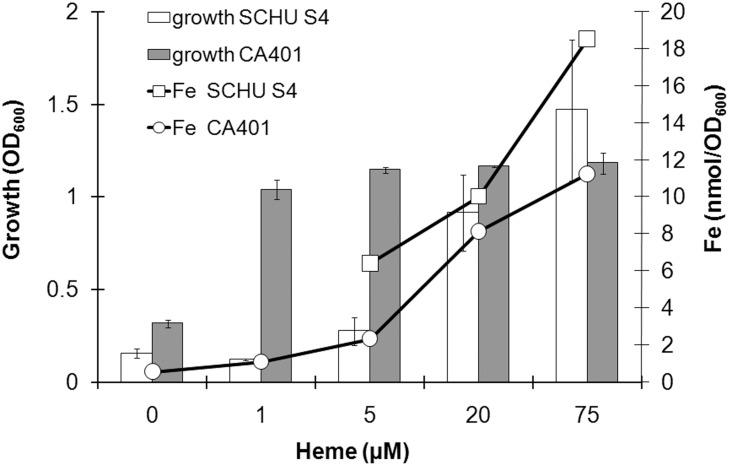
Growth response of SCHU S4 and CA401 in C-CDM to increasing heme concentrations and amounts of iron incorporated at the indicated heme concentration.Both strains were cultivated on DFO plates prior to the assays to reduce their internal storage of iron.